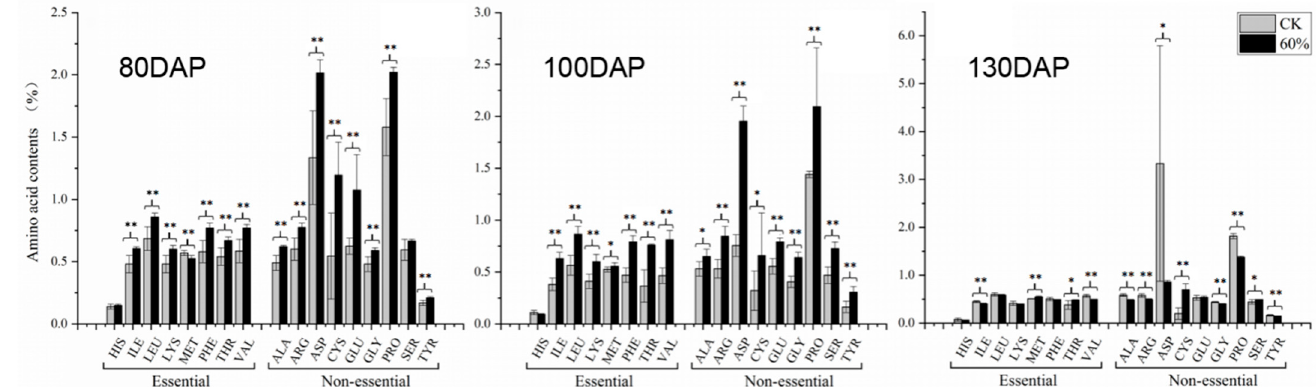
Figure 5. The contents of amino acids in developing storage roots of purple-fleshed sweet potato under shaded conditions. Data represent the mean ± SD from three individual plants (three biological replicates, n = 3) with more than two storage roots mixed per plant. The asterisks represent significant differences revealed by Student’s t -test at p < 0.05 ( * ) and p < 0.01 (**), respectively. The columns of amino acid contents from PSP storage roots under 60% shading treatment (60%) are represented by a black background and those under the nonshaded condition (CK) are represented by a grey background.